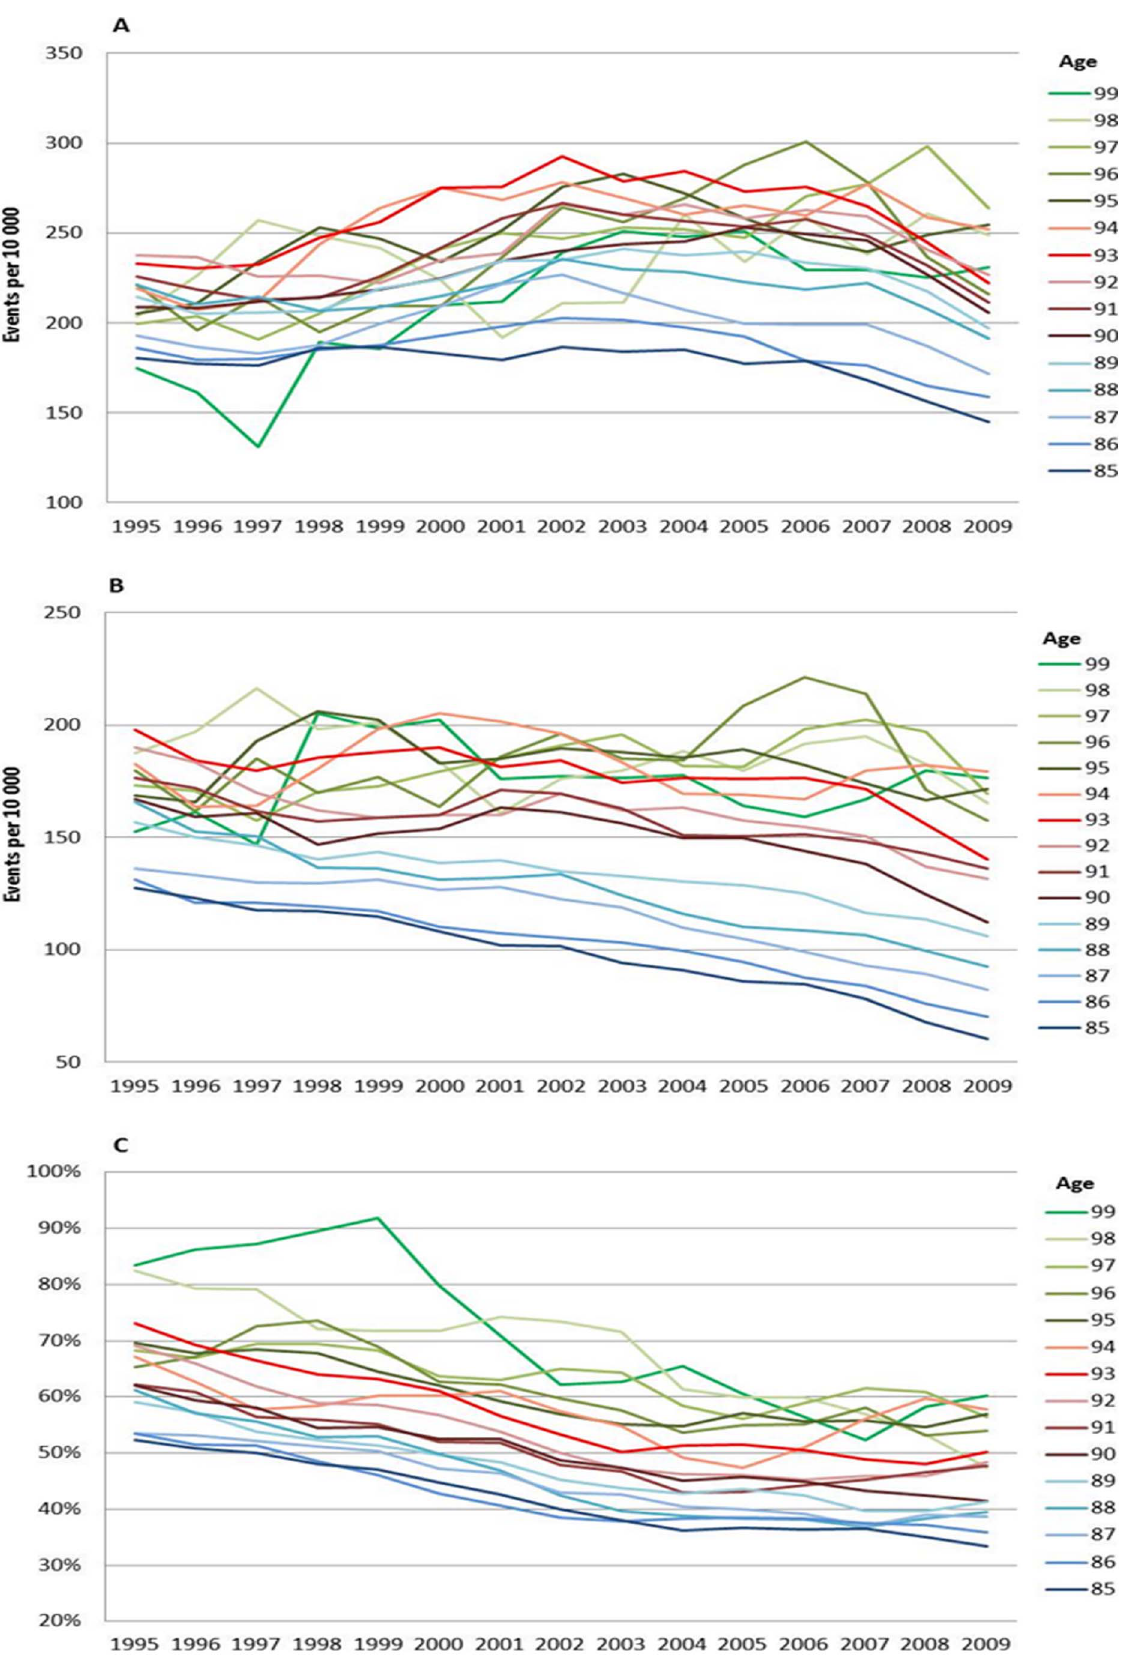
Figure 4. MI incidence (A), mortality (B) and case fatality (C), women. Age specific trends in myocardial infarction, women, between 1994 and 2010. One year cumulative incidence (A), overall mortality (B), and, case fatality within 28 days, percent (C). Three year moving average. doi:10.1371/journal.pone.0064928.g004 PLOS ONE |